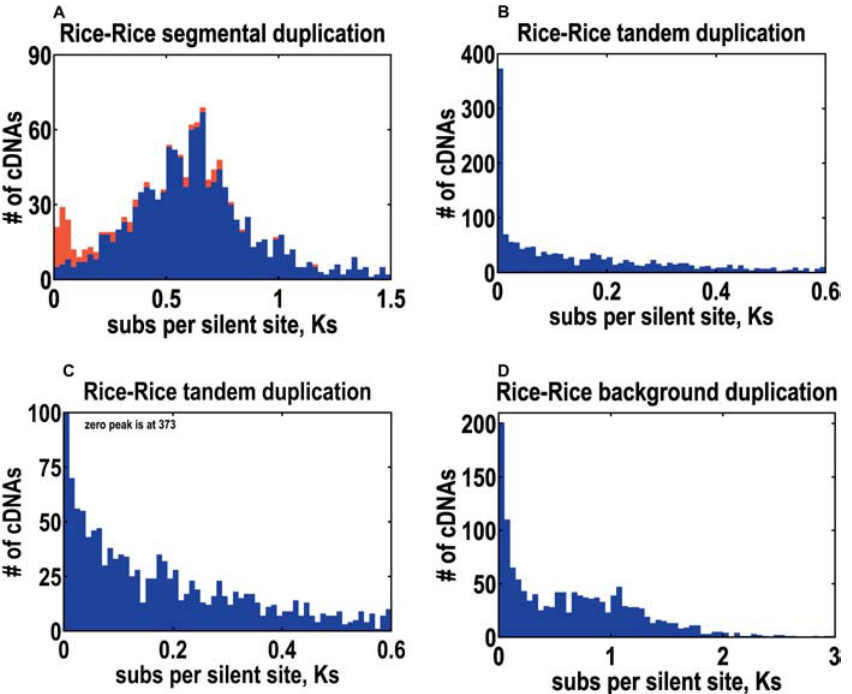
Figure 8. Distribution of Substitutions per Silent Site (Ks) for Homolog Pairs in Segmental, Tandem, and Background Duplications In (A), contributions from the recent segmental duplication on Chromosomes 11 and 12 are colored in red. The tandem duplication data are shown on two different scales, one to emphasize the magnitude of the zero peak (B) and another to highlight the exponential decay (C). Background duplications are shown in (D). DOI: